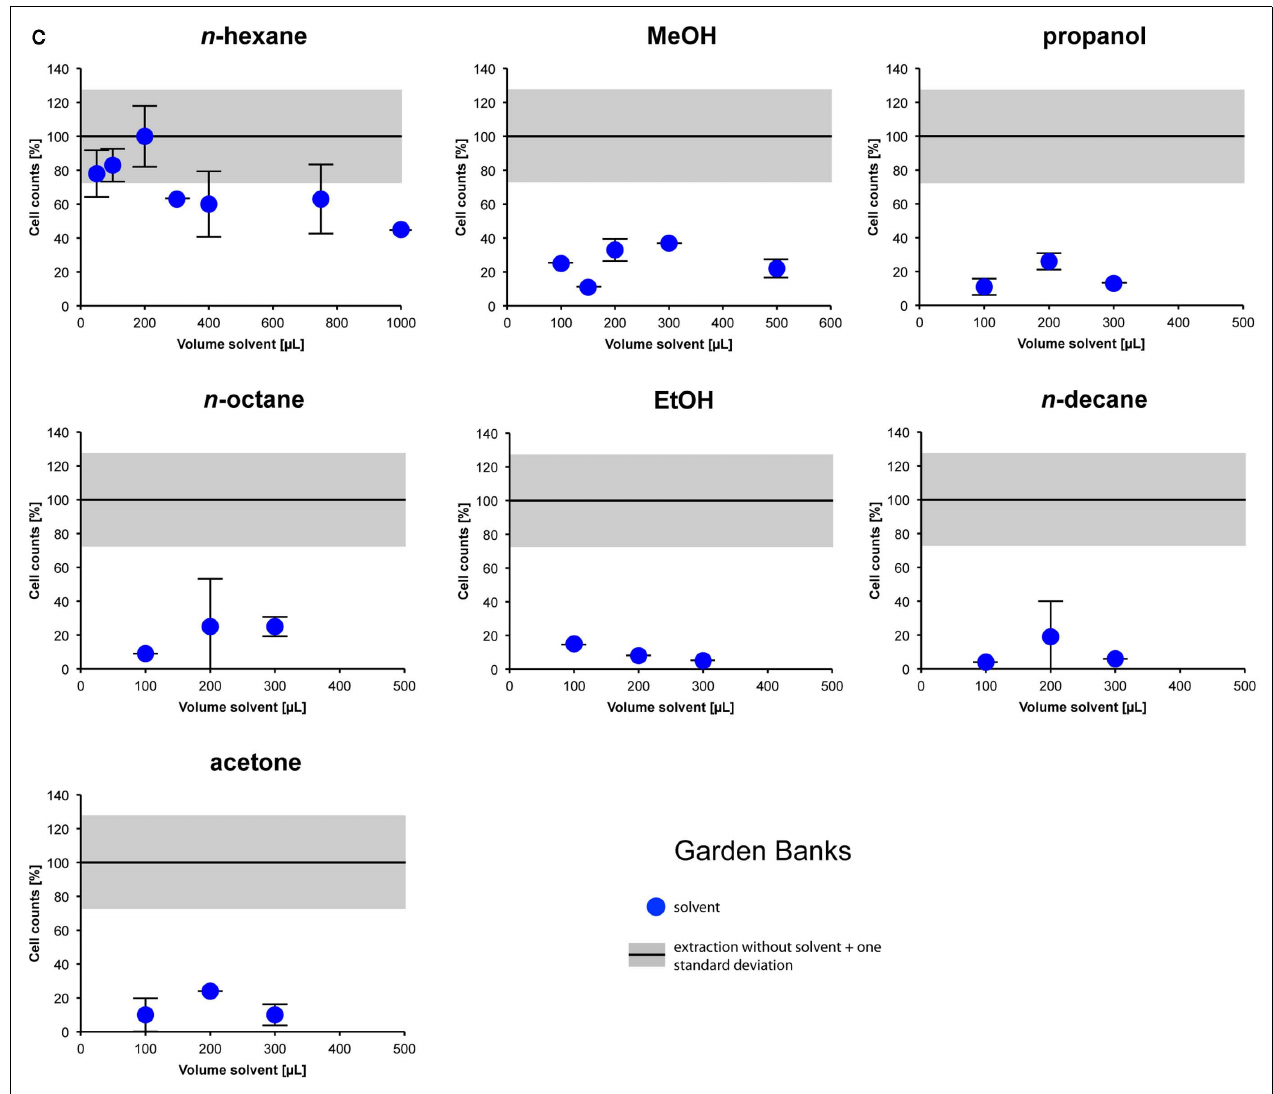
(C) Extraction of hydrocarbons with different solvents applied to an oily marine sediment sample from Garden Banks.To compare the extraction results, cell counts are given as percentages of the results of the standard procedure of Kallmeyer et al. (2008).The obtained cell counts after counting cells from untreated (i.e., without solvent) samples is set to 100%.The shaded areas represent 1 × SD for standard cell extractions without solvent treatment. None of the indicated solvents worked well at this sample, because it was almost free of